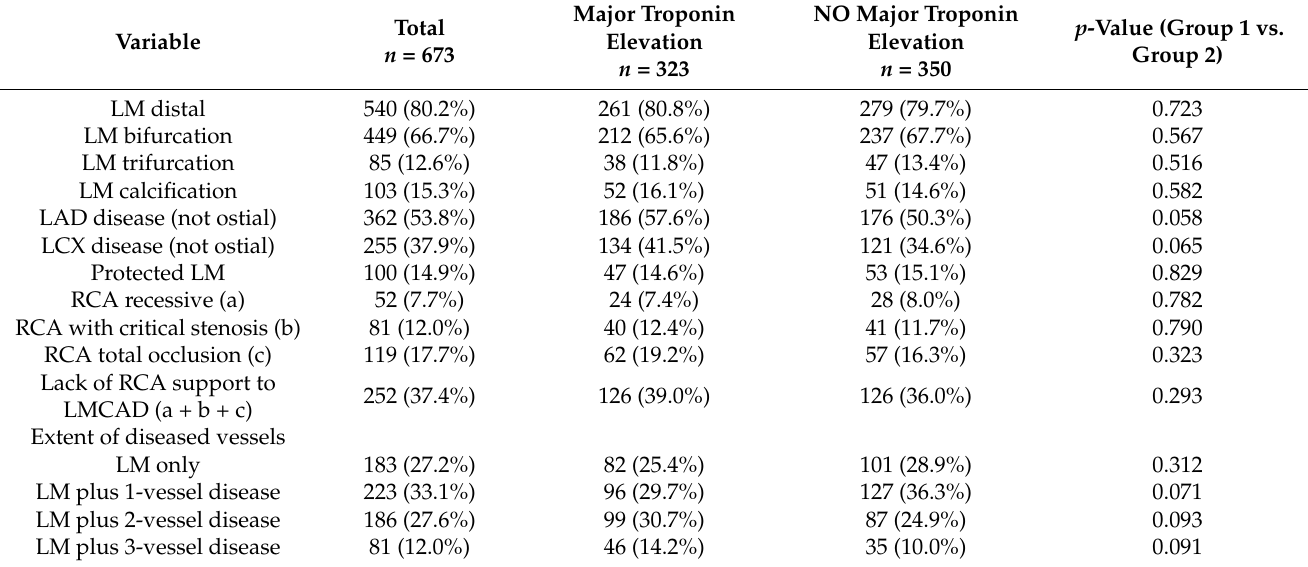
Table 3. Baseline angiographic